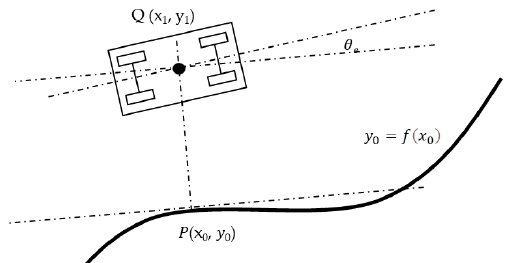
Figure 3. Features considered in the vehicle control